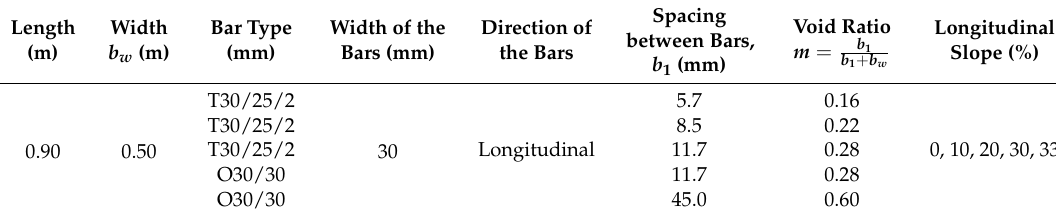
Table 1. Characteristics of the racks